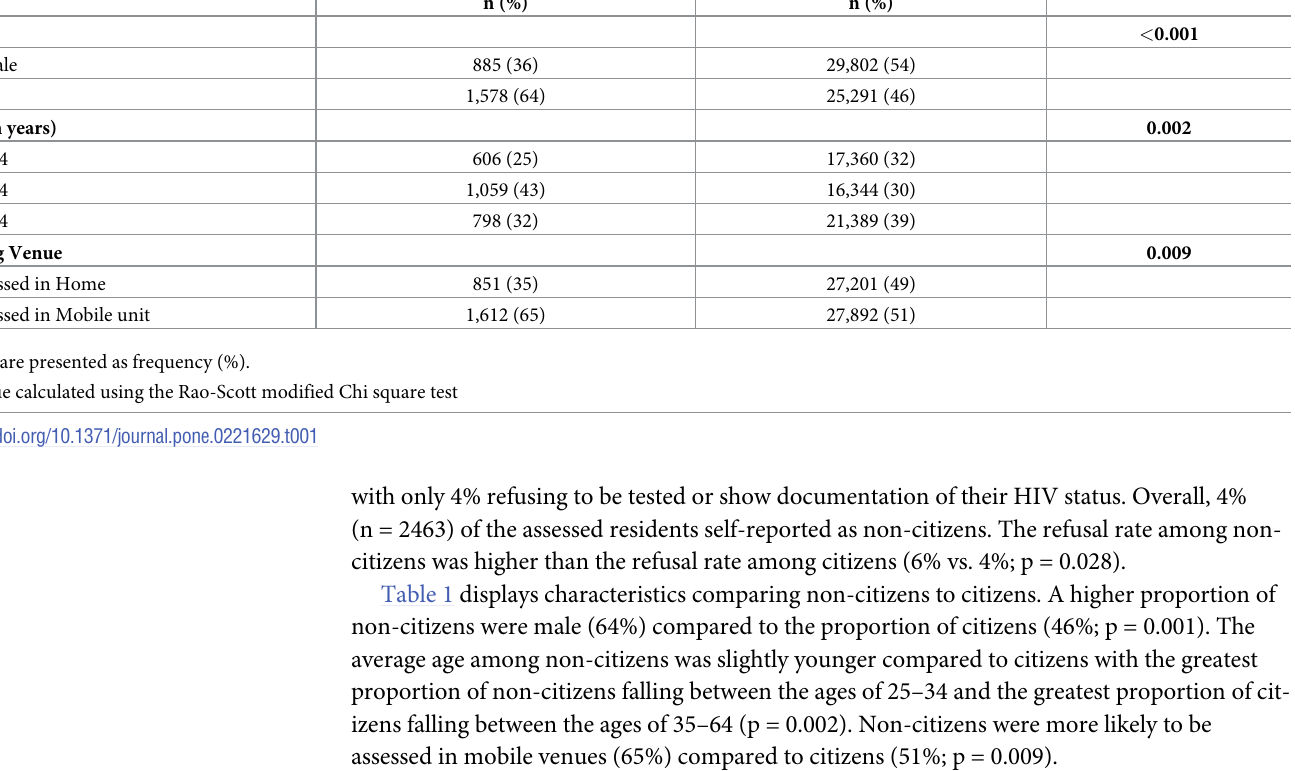
Table 1. Demographic characteristics and testing venues of individuals assessed for HIV